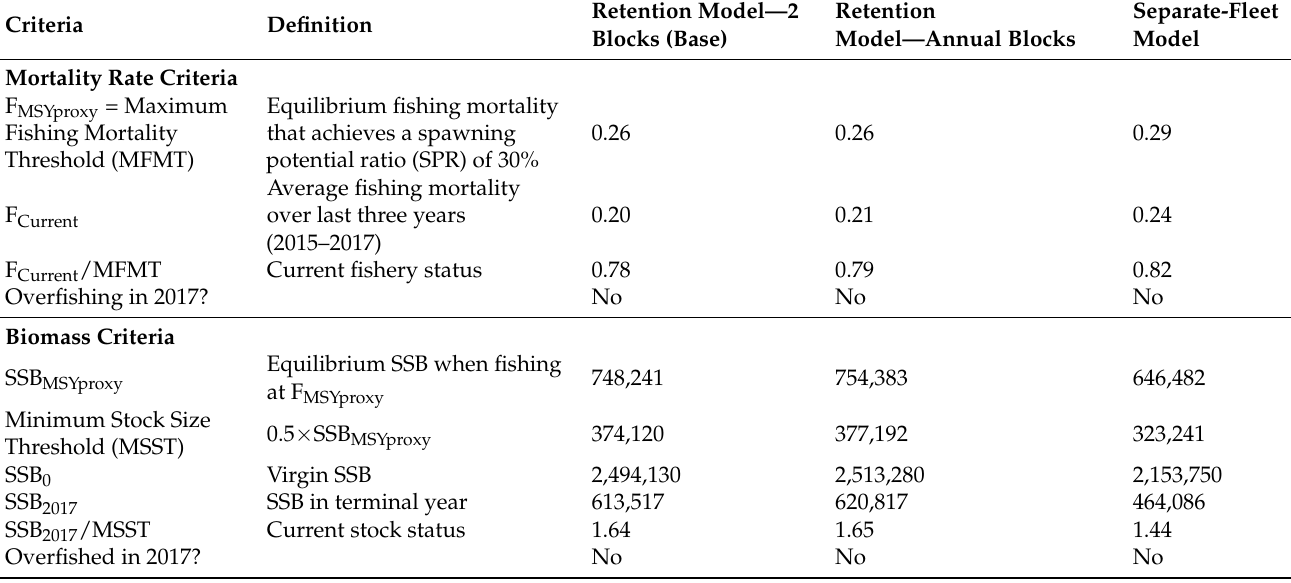
Table 3. Summary of benchmarks and reference points derived from the different modeling ap- proaches for Gulf red grouper. Spawning stock biomass (SSB) is in units of relative number of eggs, whereas F is an exploitation rate (total biomass killed/total